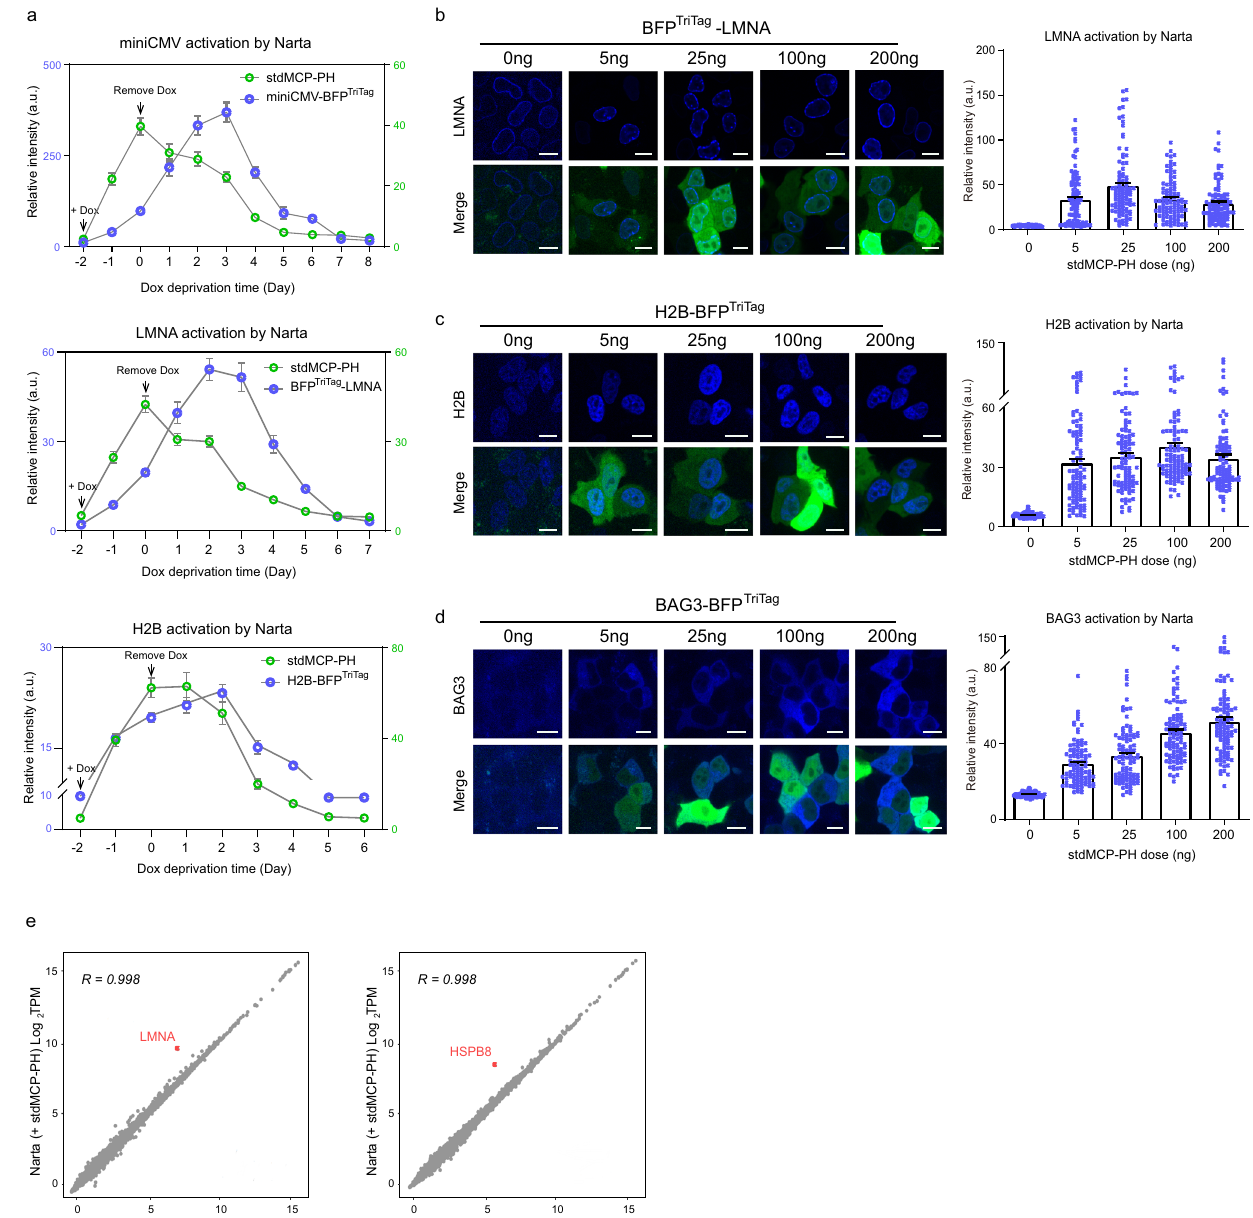
Fig. 3 | Narta-mediated gene activation is reversible, tunable and speci fi c. a Green curves showing the expression level of stdMCP-PH-T2A-GFP controlled by the doxycycline-inducible system at indicated time points. The time to add or remove Dox was indicated by arrows (Day − 2 and Day 0, respectively). The blue curves illustrate the protein expression level of exogenous (miniCMV) or endo- genous (LMNA and H2B) reporters that were related to the expression of stdMCP- PH-T2A-GFP. The protein expression level was quanti fi ed based on fl uorescent imaging. Each circle represents the mean intensity of the fl uorescent reporter of 100 cells at each time point. Error bar denotes mean±s.e.m. b – d Representative images (left) and quanti fi cations (right) to show the does-dependent effect of